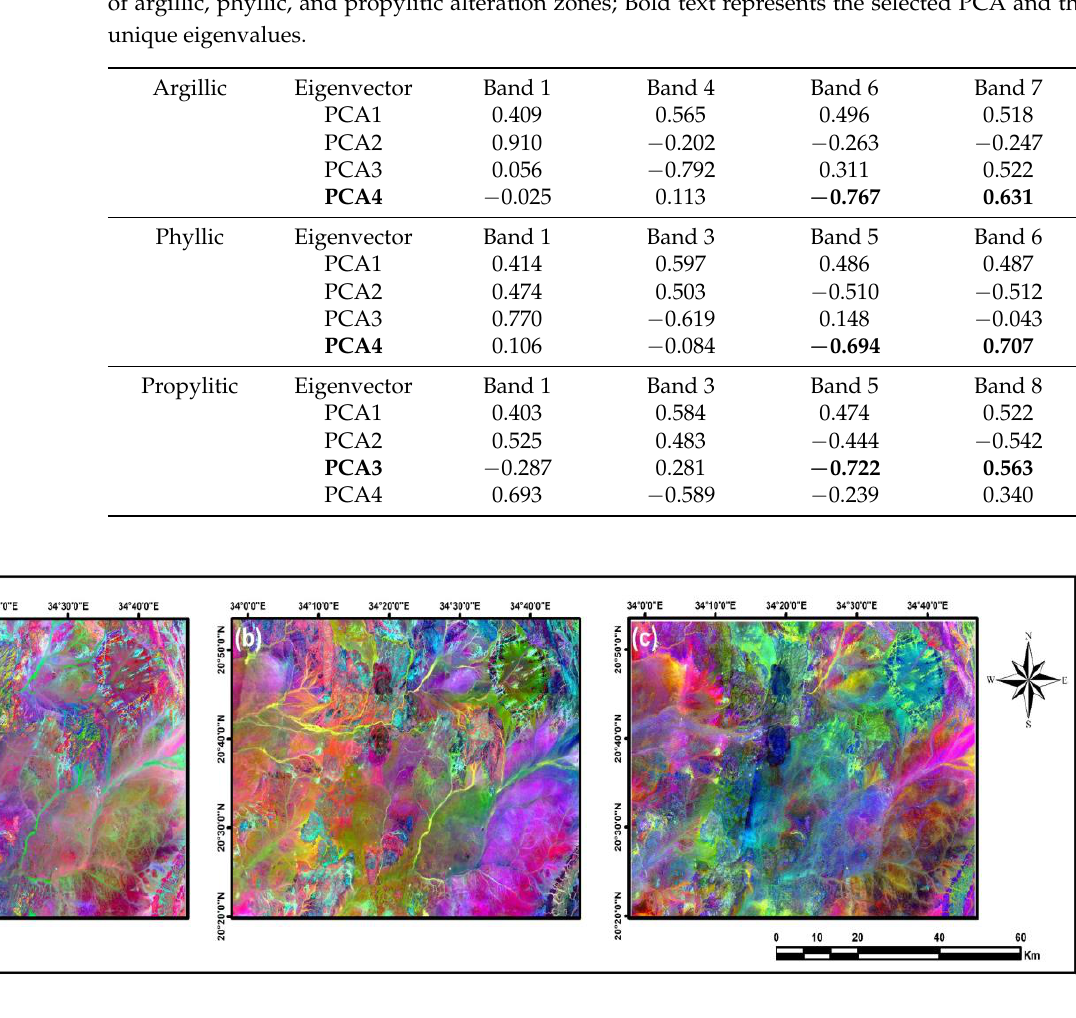
Figure 9. MNF results: ( a ) Landsat-8 MNF3, MNF4, and MNF5 in RGB.; ( b ) Sentinel-2 MNF2, MNF3, and MNF4 in RGB.; ( c ) ASTER MNF2 (negated), MNF3, and MNF 4 in RGB.